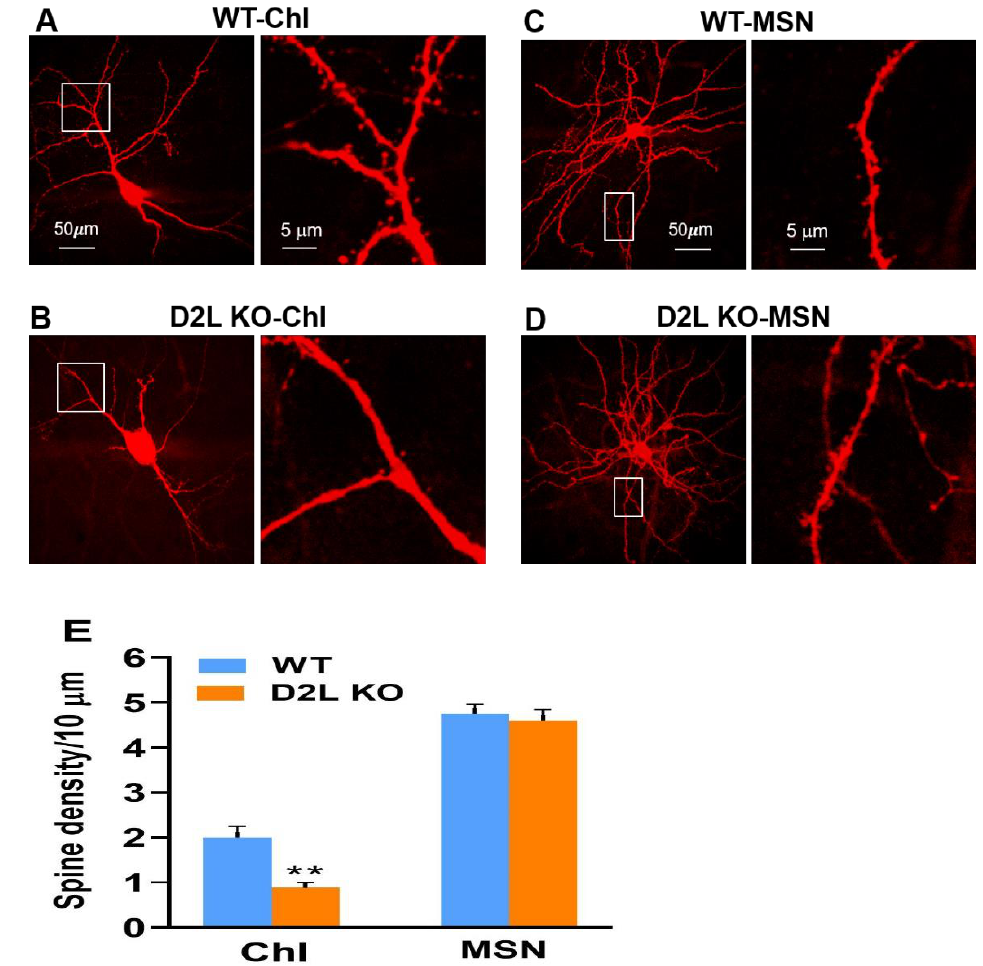
Figure 6. Dendritic spine density was reduced in striatal ChIs in D2L KO mice. ( A ) Two-photon images were taken from a representative ChI of WT mice. ( B ) two-photon images were taken from a representative ChI of D2L KO mice. Images shown on the right side (taken from white boxes in the left side images) are at a higher zoom level. ( C ) Two-photon images were taken from an MSN of WT mice. ( D ) two photon images were taken from an MSN of D2L KO mice. ( E ) Bar graph showing the mean ( ± SEM) of dendritic spine density in ChIs and MSNs from WT and D2L KO mice. There is a significant decrease in dendritic spine density of ChIs from D2L KO mice compared to those from WT mice (** p < 0.001). WT (Blue bars) and D2L KO (Orange bars).